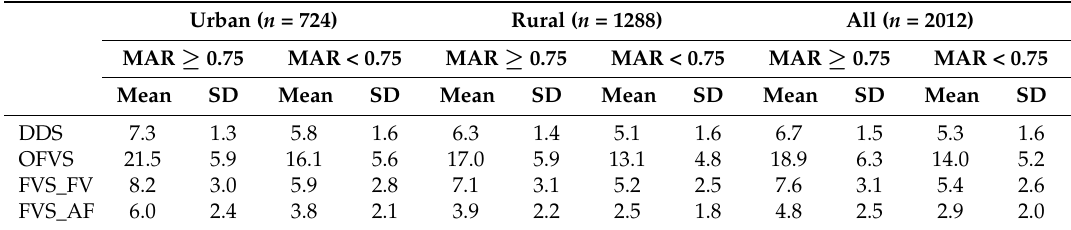
Table A1. Dietary diversity score, food variety score by region and MAR